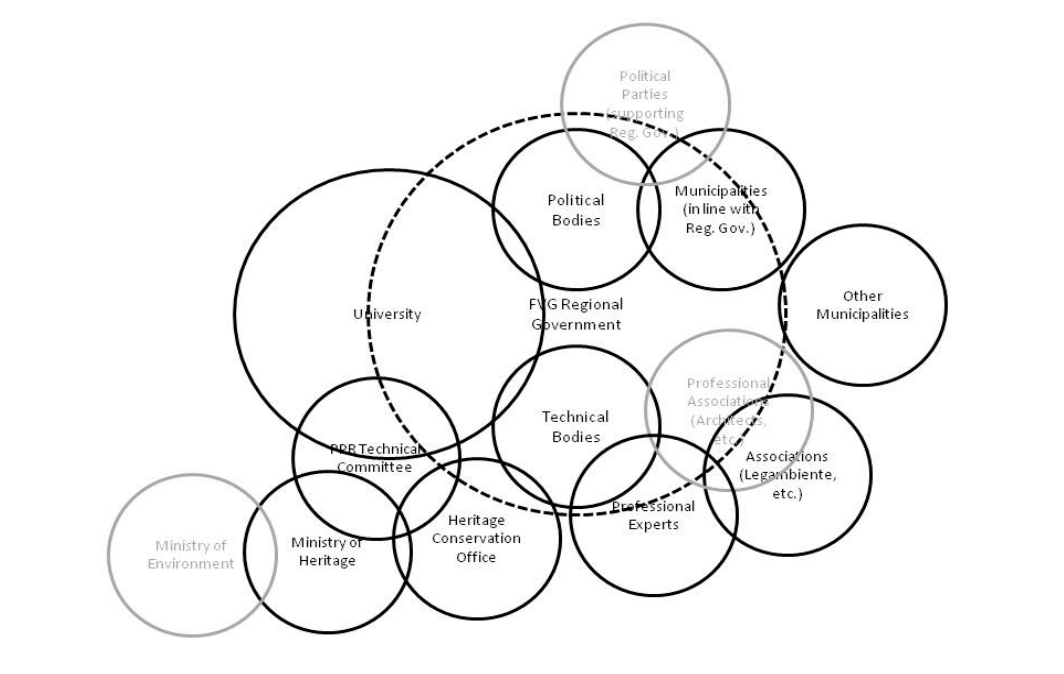
Figure 1: Top-down dynamics in knowledge co-production in relation to the Regional Landscape Plan of Friuli Venezia Giulia (in black, main actors; in grey, secondary actors; the dashed line shows the macro-category of the regional